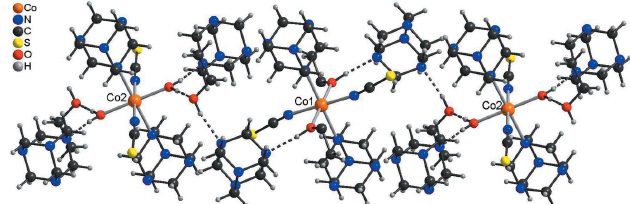
Figure 5 Part of the crystal structure of compound 1 showing the connection of the discrete complexes by the urotropine solvate molecules via inter- molecular O—H (cid:2)(cid:2)(cid:2) N hydrogen bonding (shown as dashed lines).